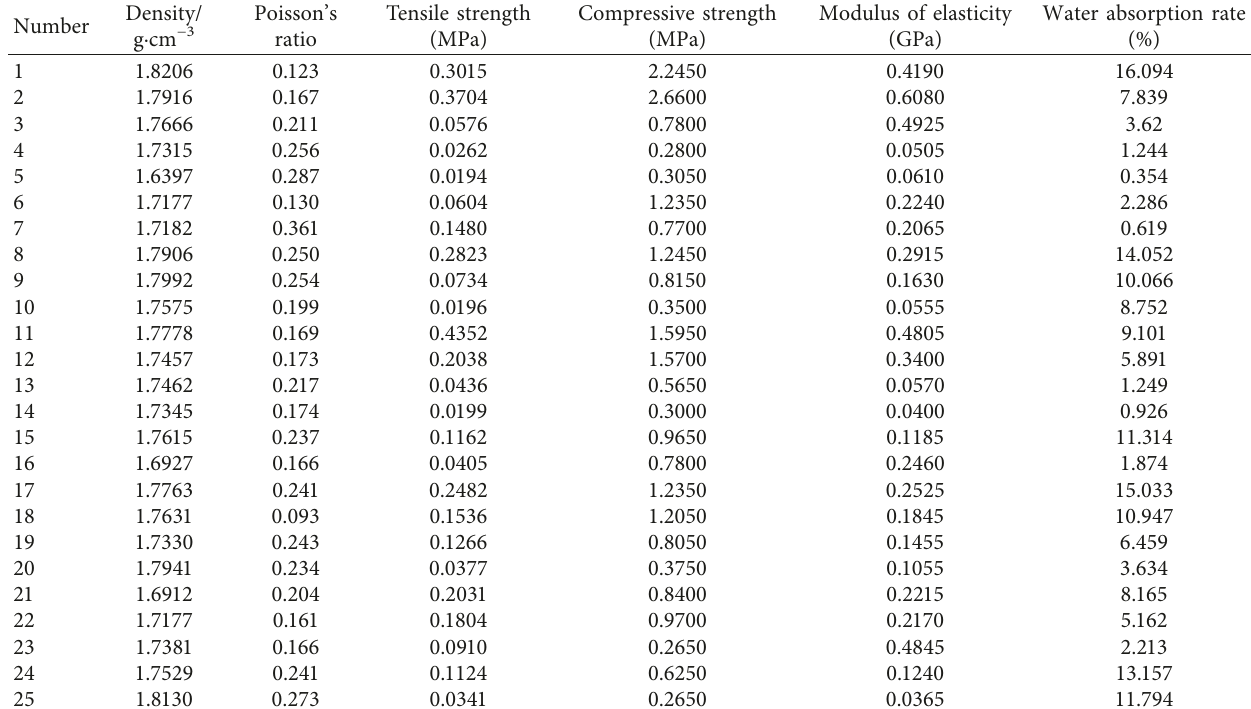
Table 2: Test results of mechanical